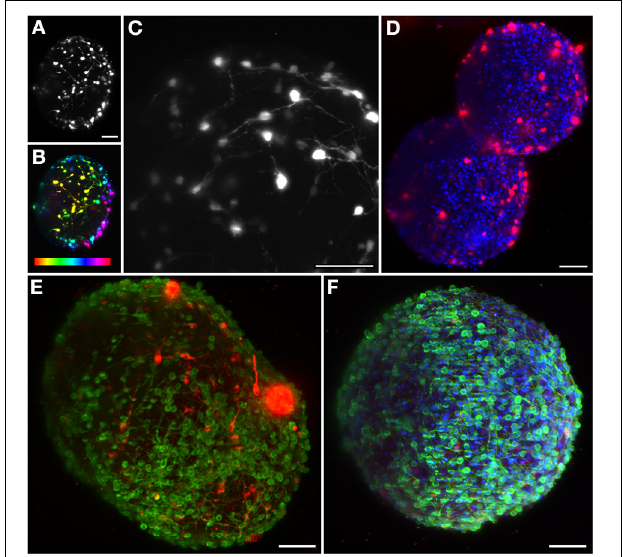
FIGURE 2 | Maximum intensity projection of different neural aggregates imaged using light sheet microscopy. (A) Differentiated hmNPC neural aggregates expressing GFP transgene. (B) Same neural aggregate with depth lookup table. Red indicates 0 μ m and purple 270 μ m. (C) Transduced differentiated neural aggregate expressing GFP transgene; Objective: 60 × . (D) Two differentiated neural aggregates with dopaminergic marker TH and TO-PRO-3 in the nuclei. (E) Differentiated neural aggregate with dopaminergic marker TH and bIII-tubulin was used as neuronal